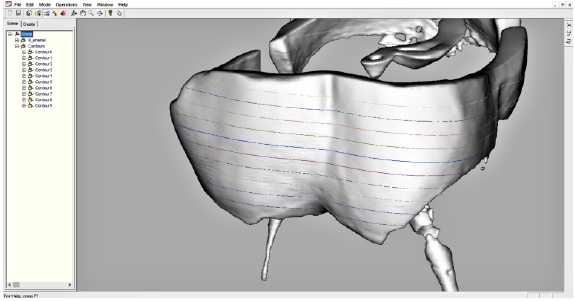
Figure 4. Reconstruction of enamel and pulpal chamber of sample lt 8 with “sliced”